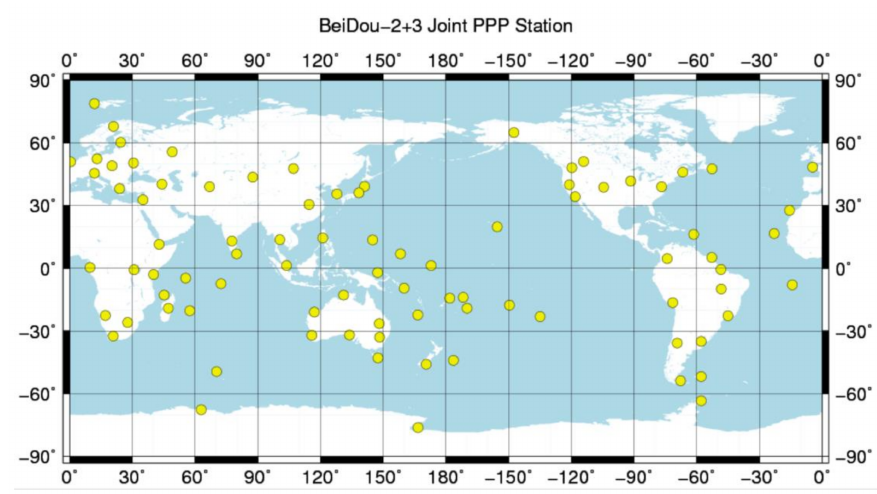
Figure 4. Station distribution of the BDS, 2+3 joint precise point positioning (PPP) test.